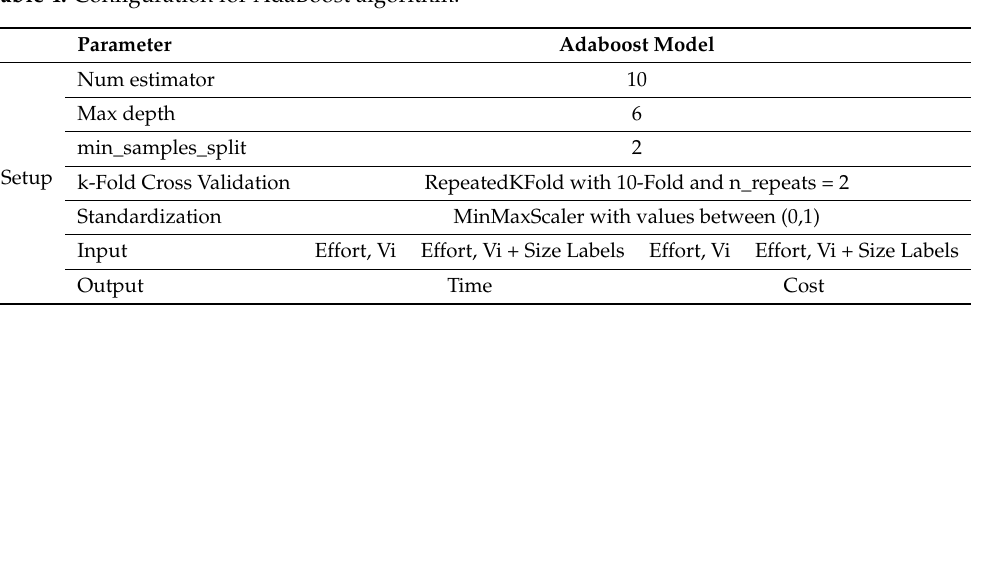
Table 4. Configuration for AdaBoost